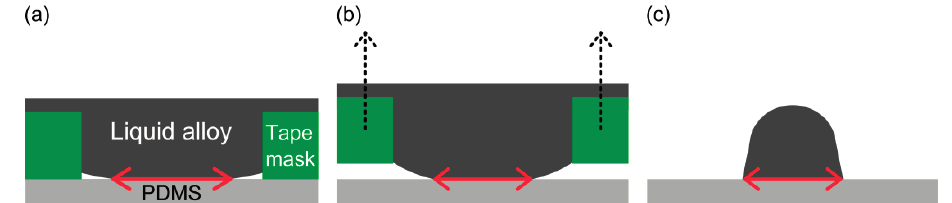
Figure 4. Conceptual drawing of the cross section structure of tape transfer printing of a liquid alloy where the red arrow represents wetting length of liquid alloy on PDMS (not scaled): ( a ) The printed liquid alloy on PDMS with a tape mask; ( b ) The tape mask peeling off from PDMS; and ( c ) Line width decrease of the printed liquid alloy pattern after mask